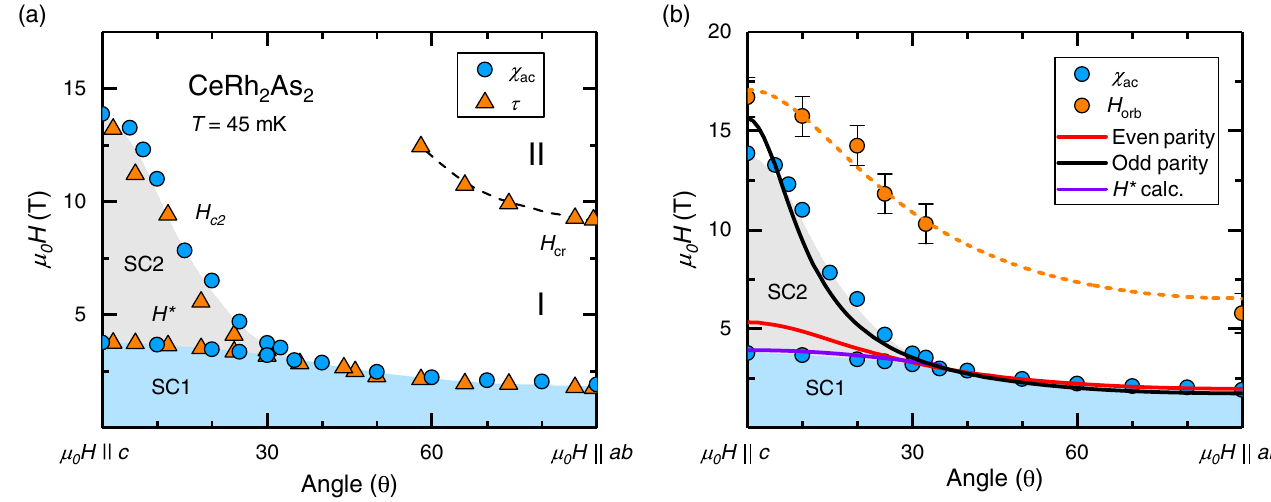
FIG. 2. Angle dependence of the critical fields at 45 mK. (a) Different symbols represent different experimental techniques as indicated. H indicates a transition between two ordered states I and II [9]. Since it shows a strong hysteresis, only the critical fields cr from up sweeps are shown here. The critical fields from the down sweeps are typically around 1 T lower. (b) Angle dependence of the upper critical fields of SC1 and SC2 as well as the orbital limit H of SC1 obtained from the phase diagrams in Fig. 4 and a fit of it orb using Eq. (1) (orange dashed line). Red and black lines are fits to Eq. (2) at 45 mK, and the violet line reflects the calculated H (cid:2) , as detailed in the main text and Ref. [20].